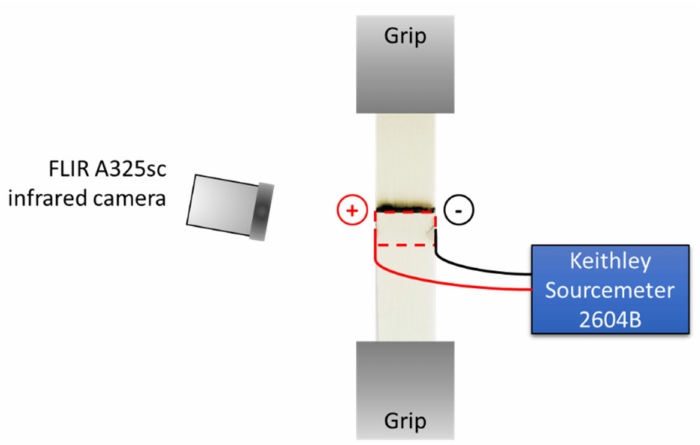
Figure 3. Disassembly setup with infrared camera and sourcemeter. The dashed rectangle indicates the surface area that was monitored for temperature during the tests. Not to